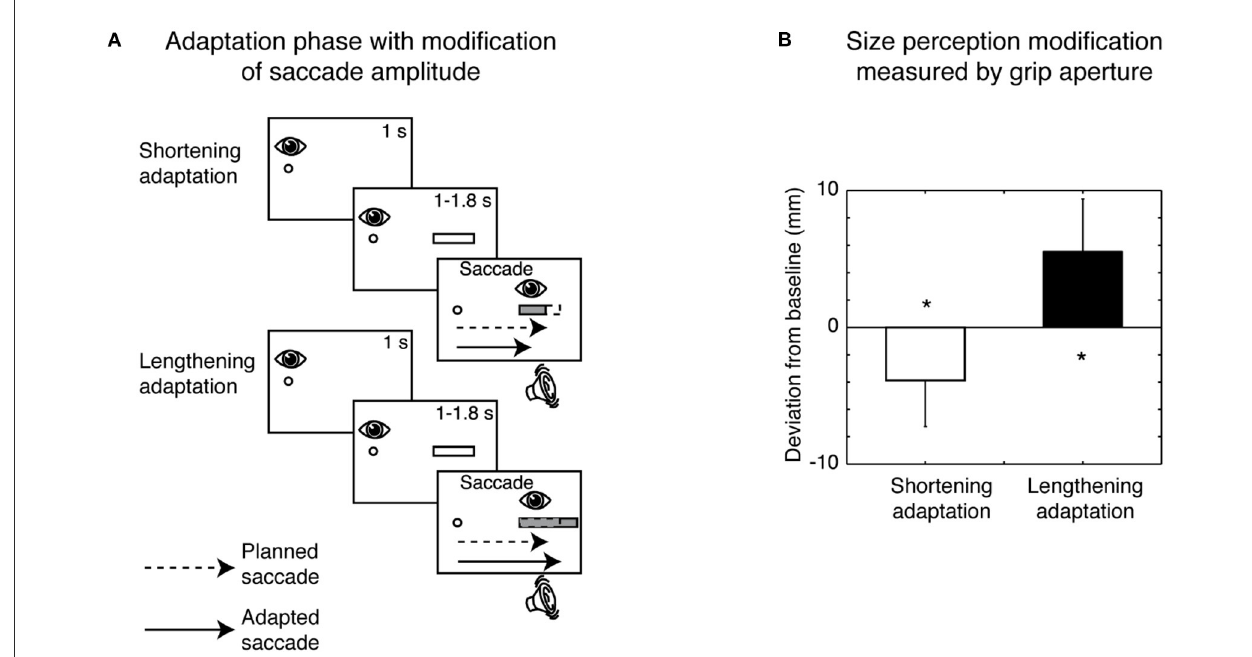
FIGURE4 Size perception modification induced by saccadic adaptation. (A) Top row, Shortening adaptation condition. The fixation point was presented at the start of the trial. After 1s, a bar appeared, but participants had to continue to focus on the fixation target. After a randomized time, an acoustic signal indicated the possibility of executing a saccade toward the bar. Then the bar was decreased in size by 30% of its length at the right border as soon as the saccade was detected. Bottom row, Lengthening adaptation phase. This condition was identical to the shortening adaptation condition, with the only difference being that the bar was increased in size by 30% during saccade execution. (B) Mean deviation of grip aperture from baseline in shortening adaptation (white column) and lengthening (black column) adaptation. The data were averaged across subjects and sizes. Error bars indicate SE. * p < 0.05, significant deviations from baseline (modified from Bosco et al.,